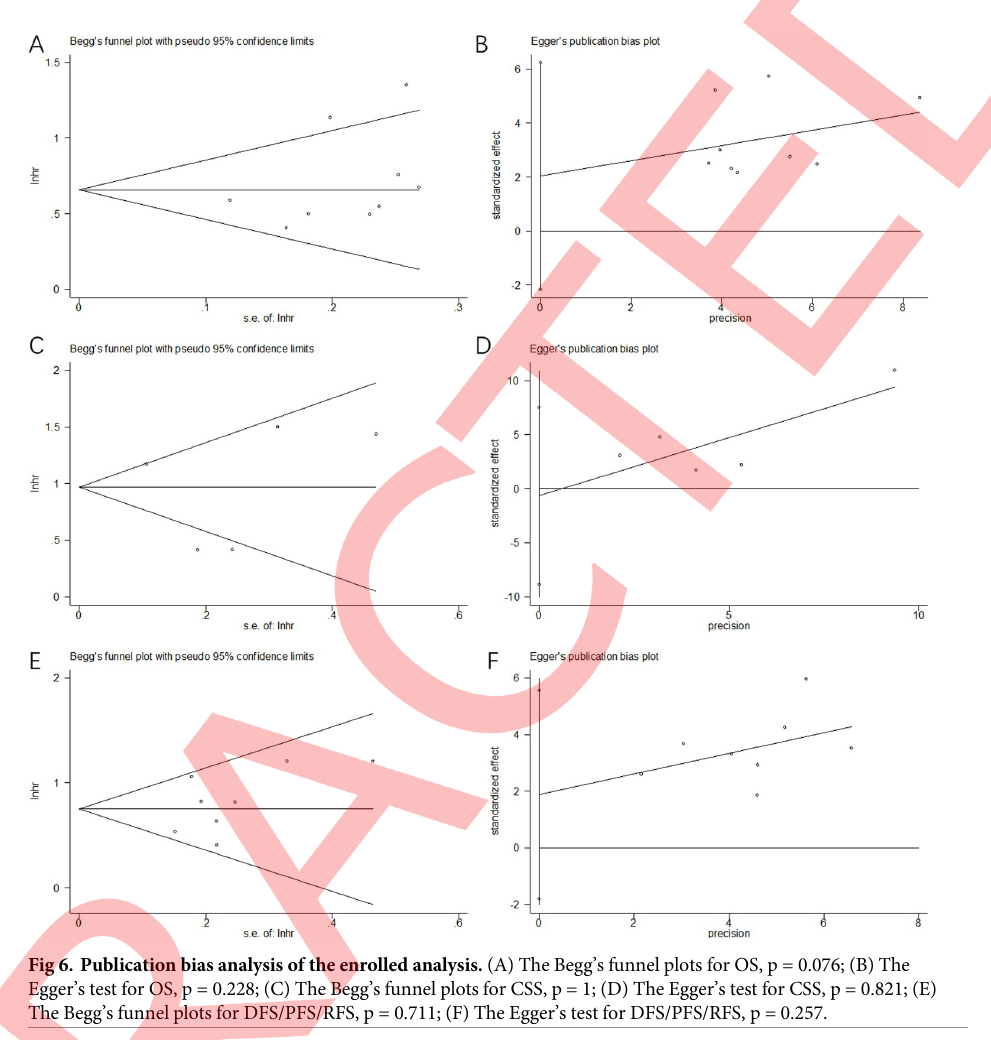
Fig 6. Publication bias analysis of the enrolled analysis. (A) The Begg’s funnel plots for OS, p = 0.076; (B) The Egger’s test for OS, p = 0.228; (C) The Begg’s funnel plots for CSS, p = 1; (D) The Egger’s test for CSS, p = 0.821; (E) The Begg’s funnel plots for DFS/PFS/RFS, p = 0.711; (F) The Egger’s test for DFS/PFS/RFS, p =